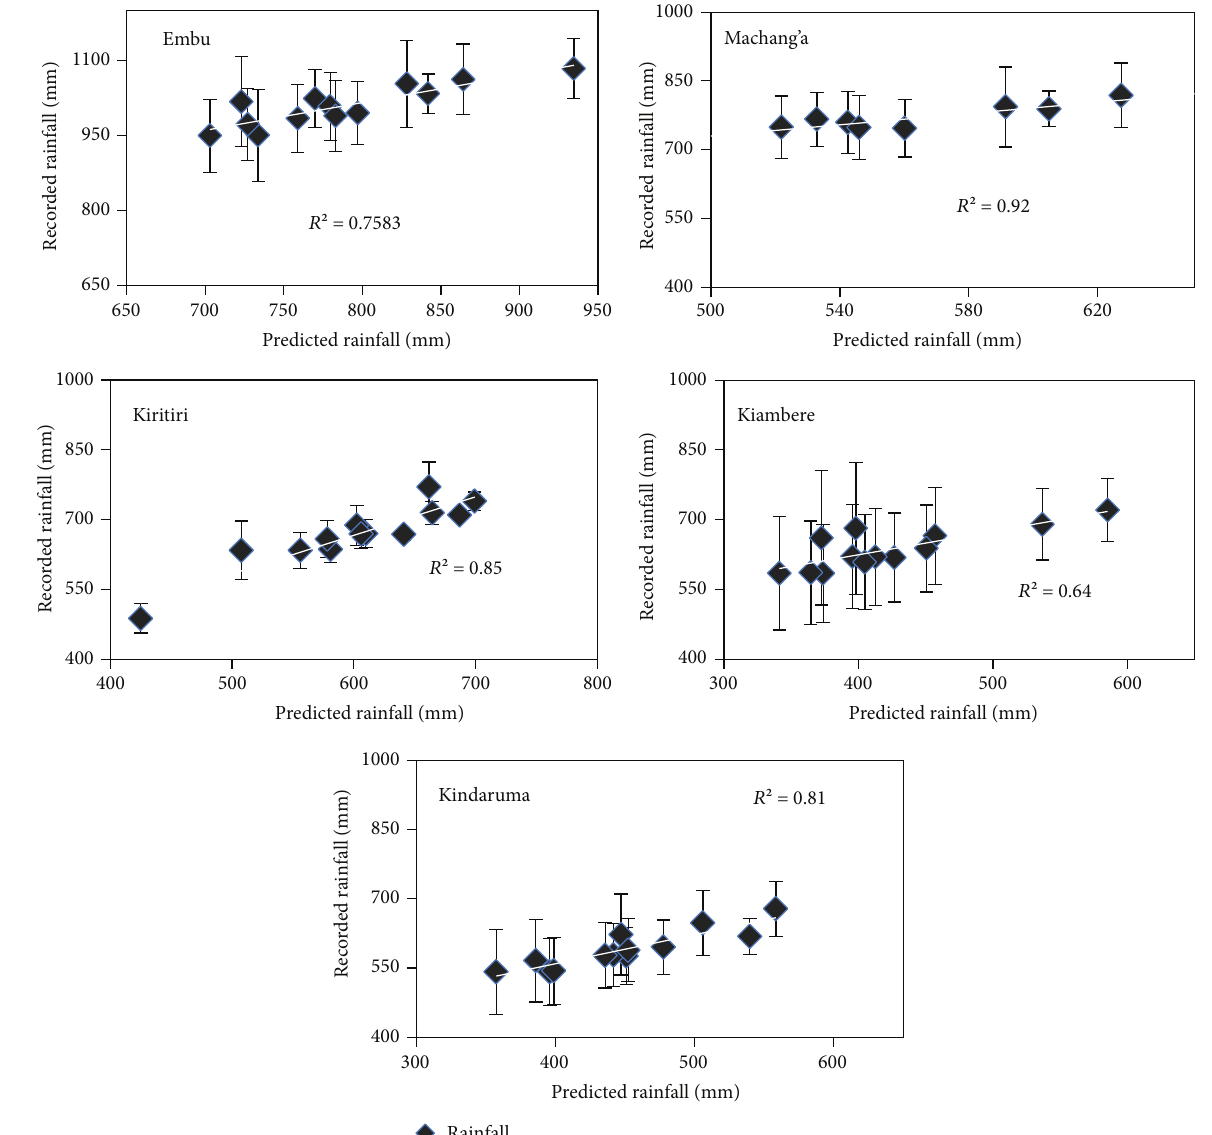
Figure 8: Comparison between recorded and ArCGIS Kriging predicted average decadal rainfall amount across study stations: error bars denote standard deviation of observed means, 𝑛 = 13